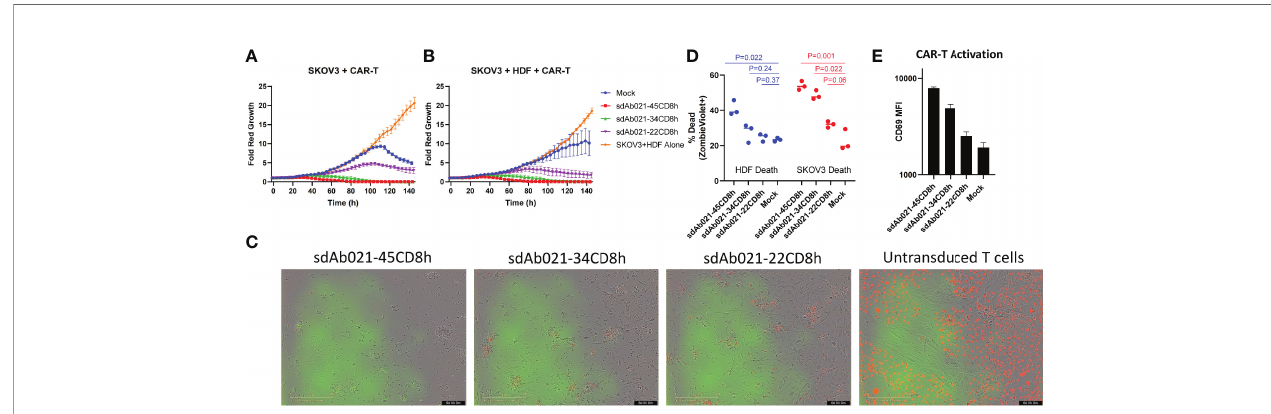
FIGURE 6 | Hinge truncated CAR-T cells maintain enhanced tumor selectivity in triple co-cultures with both healthy donor cells and SKOV3 tumor cells. Hinge variant EGFR sdCAR cells were placed in co-culture with (A) equal number of mKate2-expressing SKOV3 cells or (B) equal numbers of SKOV3 and unmodi fi ed human healthy donor derived dermal fi broblasts (HDF). Graphs depict the average fold change in growth of red fl uorescent tumor cells over time from CAR-T cells derived from 3 independent donors. (C) Pictures show the state of triple co-cultures after 6 days of incubation. In a similar experiment, triple co-cultures of hinge variant EGFR-sdCAR cells, HDF, and SKOV3 cells were incubated overnight before examining (D) HDF or SKOV3 viability and (E) T-cell activation marker CD69 expression via fl ow cytometry. Graphs depict the mean results for CAR-T or control T cells from 3 independent blood donors. P values indicate a student T-test comparison for variance between differing hinge constructs, an ANOVA comparison of survival curves is also shown where